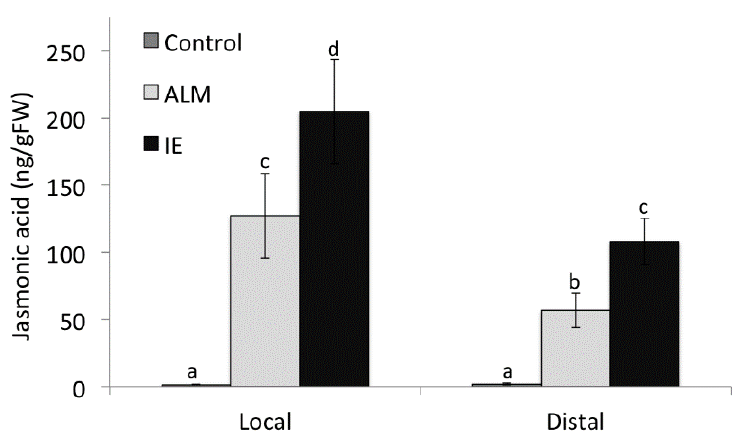
Figure 4. Comparison of insect elicitor (IE) and alamethicin (ALM) on local and distal jasmonic acid accumulation. Different letters above each bar indicate statistical difference determined by ANOVA analysis followed by Tukey tests where appropriate ( p < 0.05). N = 4, error bars represent standard deviation.